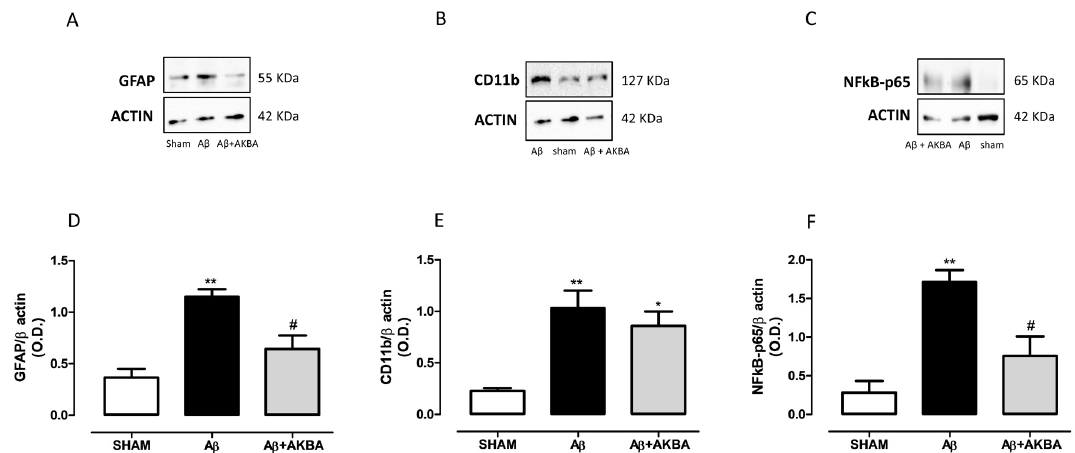
Figure 7. Effects of AKBA administration on hippocampal GFAP, CD11b and NFkB-p65 levels. Representative image of Western blotting of ( A ) GFAP, ( B ) CD11b and ( C ) NFkB-p65. ( D ) Quantification of the optical density of GFAP bands normalized to the actin protein value in the HIPP of mice 7 days after icv injection of vehicle (SHAM, 5 µL, white bar), A β (A β , 4 µM, black bar), and A β +AKBA (A β , 4 µM + sublingual AKBA, 5 mg/kg, gray bar), (SHAM n = 5, A β n = 3, A β +AKBA n = 5). ( E ) Quantification of the optical density of CD11b bands normalized to the actin protein value in the PFC of mice 7 days after icv injection of vehicle (SHAM, 5 µL, white bar), A β (A β , 4 µM, black bar), and A β +AKBA (A β , 4 µM + sublingual AKBA, 5 mg/kg, gray bar), (SHAM n = 4, A β n = 5, A β +AKBA n = 4). ( E ) Quantification of the optical density of NFkB-p65 bands normalized to the actin protein value in the PFC of mice 7 days after icv injection of vehicle (SHAM, 5 µL, white bar), A β (A β , 4 µM, black bar), and A β +AKBA (A β , 4 µM + sublingual AKBA, 5 mg/kg, gray bar), ( F ) SHAM n = 3, A β n = 4, A β +AKBA n = 4). One-way ANOVA followed by Tukey’s multiple comparison test, ** p < 0.01 A β versus SHAM; * p < 0.05 A β +AKBA versus SHAM; # p < 0.05 A β +AKBA versus A β .